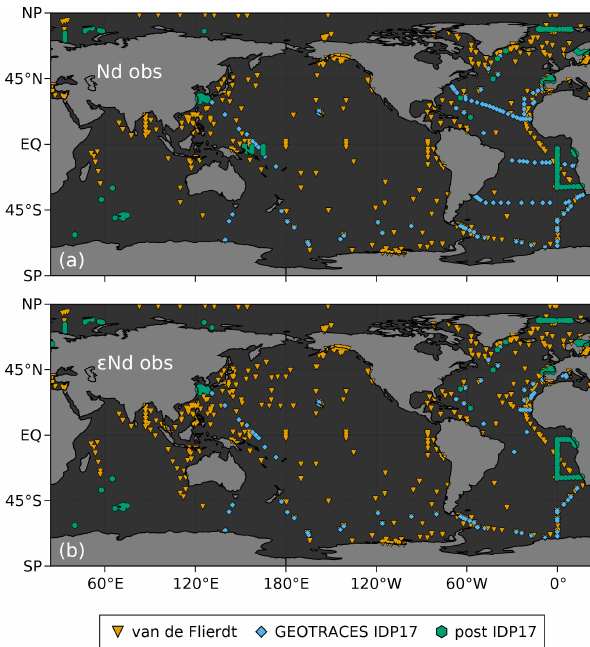
Figure 6. Locations of (a) Nd and (b) ε Nd observations used in this study, labeled per the data